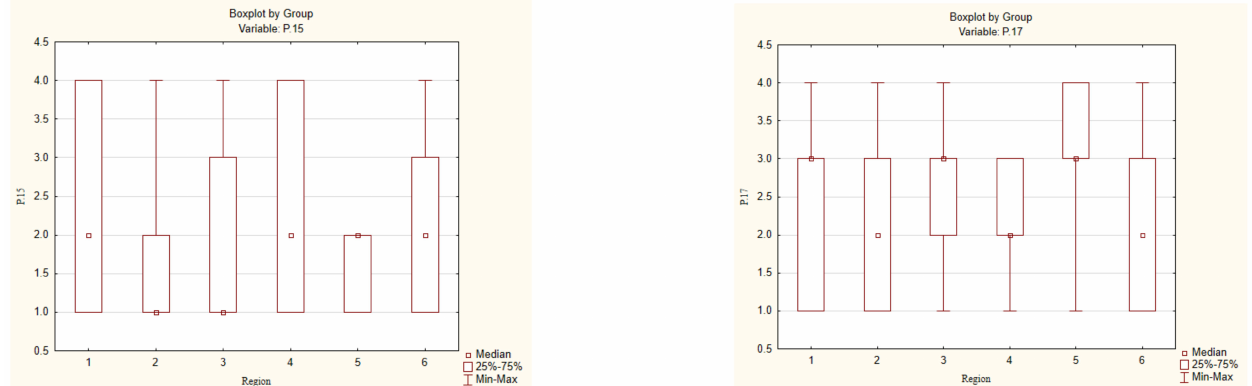
Figure 7. Box and whisker diagrams for practice P15 (Using toothbrush cup) and P17 (Taking short showers), category— “Water saving”.